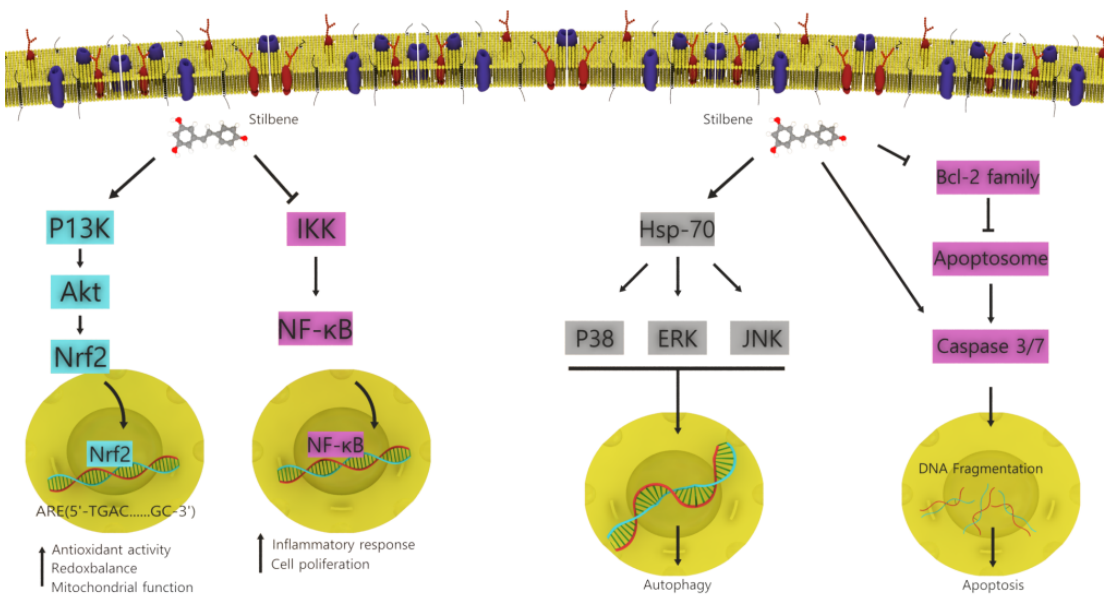
Figure 6. Mechanism of action of stilbenoids. Stilbenoids induces apoptosis through the caspase activation pathway; they also suppress Bcl-2 expression and apoptosome production. Stilbenoids induce autophagy in cancer cells in an hsp-70 dependent mechanism. These compounds suppress the NF- κ B signaling pathway that plays an important role in inflammation. They also activate the Nrf2 antioxidant defense system (adopted with modification from [107]).